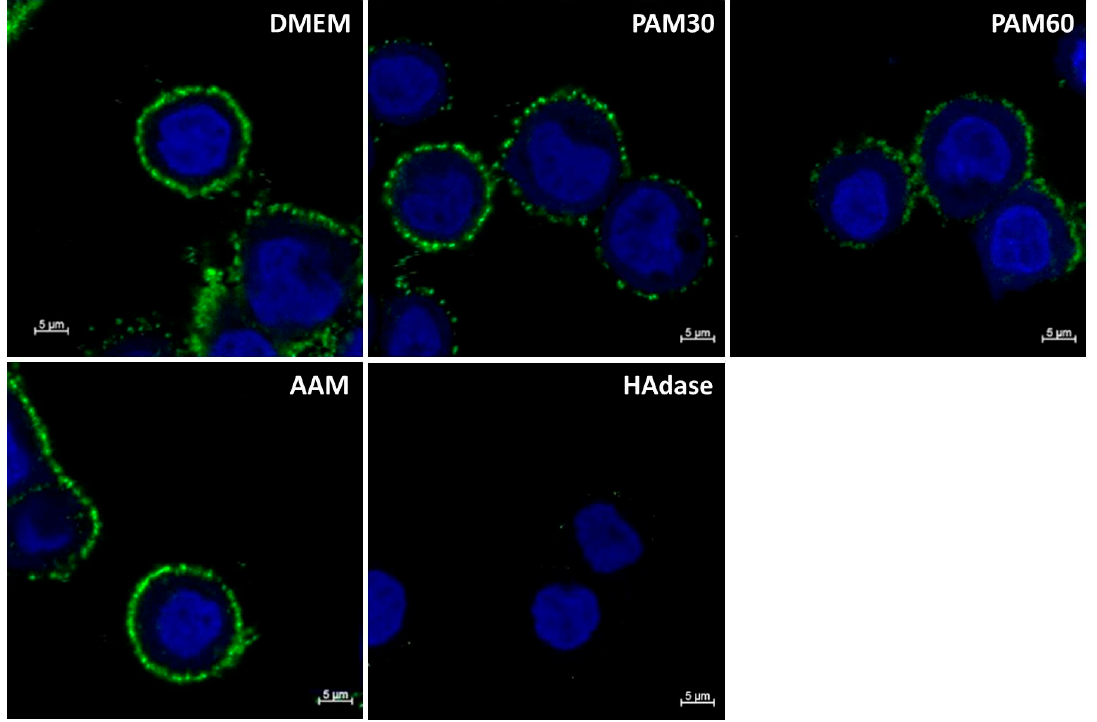
Figure 3. Immune fluorescence images of the HA pericellular coat of HaCaT cells (HA—green, nuclei —blue) after cultivation in PAM or control media for 6 h. Note that the HA coat was reduced in PAM30 and PAM60. (LSM780, Carl Zeiss, objective 63 × oil, zoom 2.5, bar = 5 µm). Abbr.: DMEM: Dulbecco’s modified Eagle’s medium, PAM30: 30 s plasma-treated DMEM, PAM60: 60 s plasma-treated